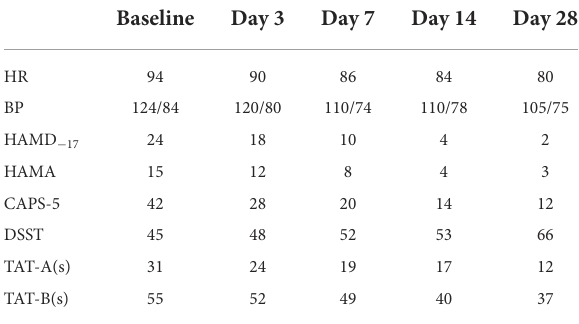
TABLE 2 Effects of prazosin on heart rate, blood pressure, and emotional and cognitive symptoms of